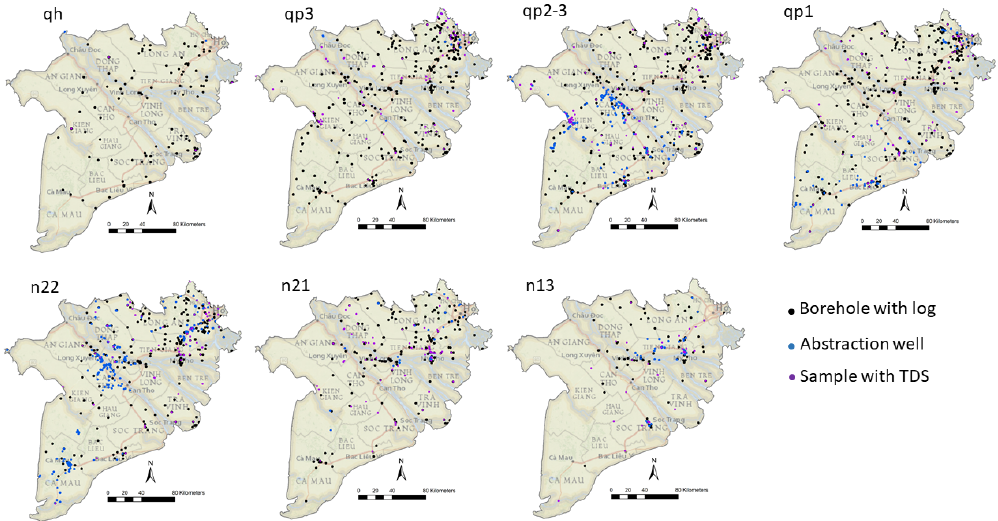
Figure 4. Spatial distribution of the used data that are applied for each aquifer. The data density for the deepest aquifer – n13 – is not sufficient to produce adequate estimates of groundwater salinity concentrations and is therefore discarded from further analysis. Map copyright: © National Geographic, Esri, Garmin, HERE, UNEP-WCMC, USGS, NASA, ESA, METI, NCRAN, GEBCO, NOAA, increment P